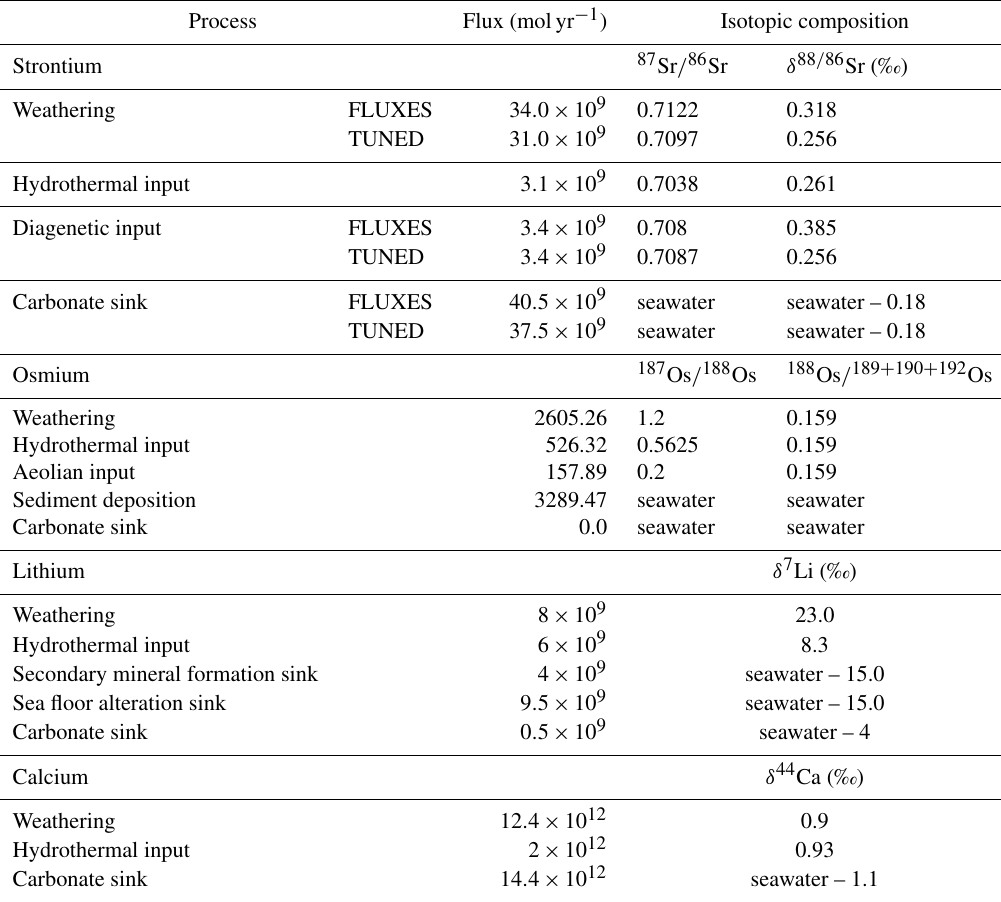
Table 6. Metal fluxes for pre-industrial